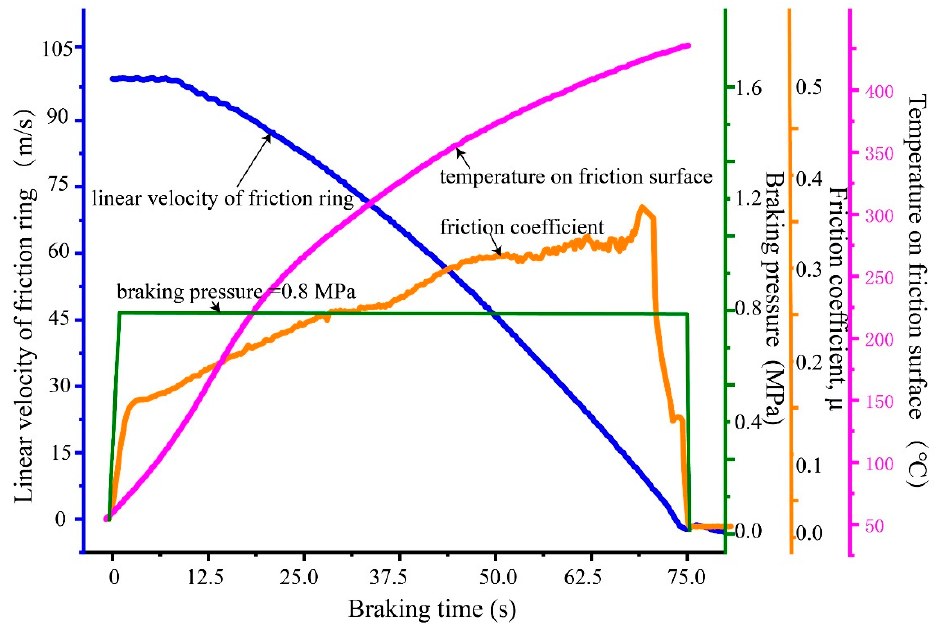
Figure 19. Friction experiment data of the braking ring against powder metallurgy (PM) pins at IBV 97 m/s and 0.80 MPa.